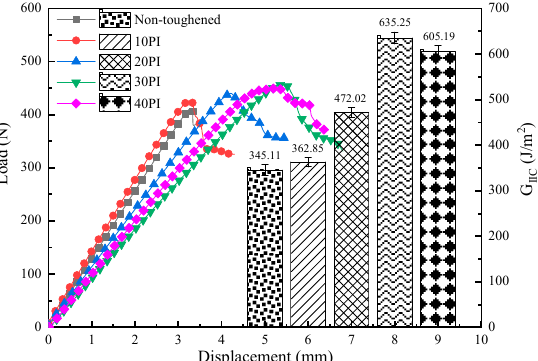
Figure 4. SEM images of delaminated surfaces of ( a ) 10 PI-toughened composite, ( b ) 20 PI-toughened composite, ( c ) 30 PI-toughened composite, and ( d ) 40 PI-toughened composite after DCB tests.